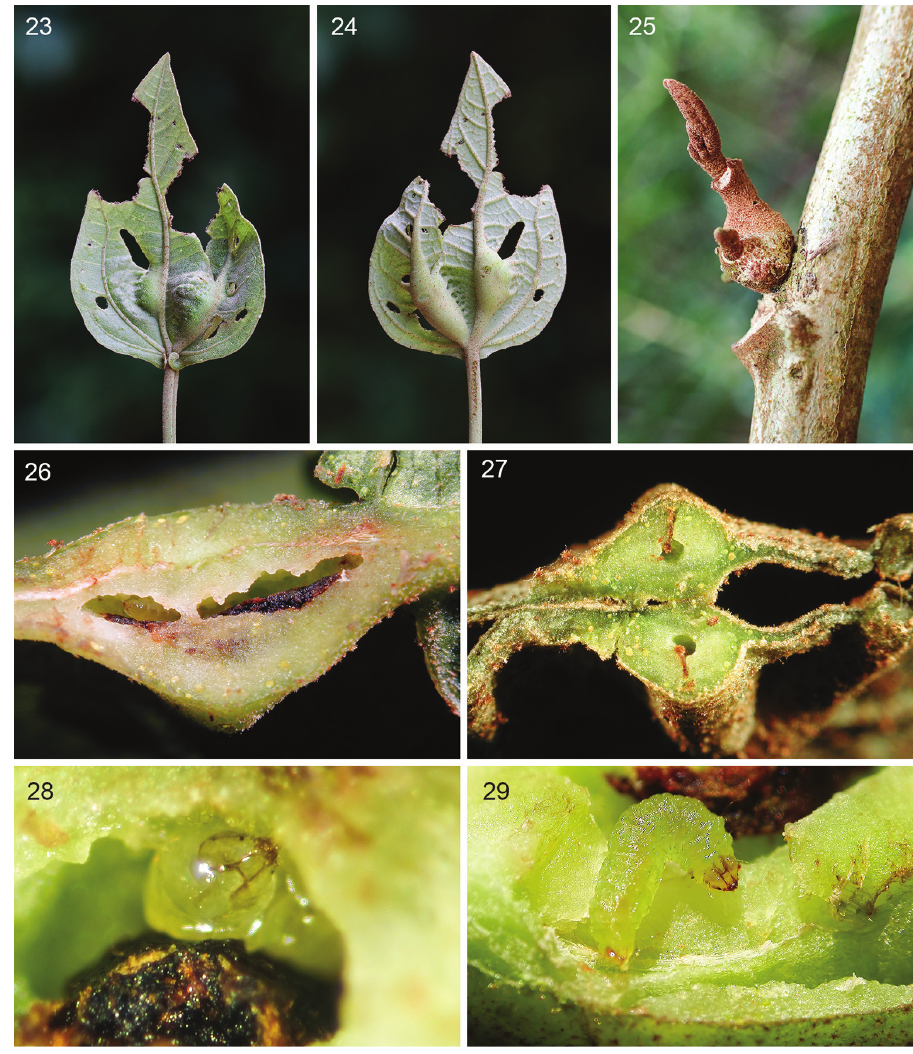
Figures 23–29. Stigmella gallicola , galls and larvae in Hampea appendiculata , details, all at Estación Biológica Monteverde, 1530 m. 23, 24 Galls on primary leaf veins of young leaf, respectively adaxial and abaxial view, 8 June 2016 25 Old gall found at axillary leaf bud, same date 26 Longitudinal cut of mature gall with late instar larva in situ, 20 October 2001 27 Transversely cut leaf (young gall in middle) showing gall chamber and frass mass line, 24 October 2001 28 Late instar larva in situ, note packed frass in gall chamber, same date 29 Late instar larva, dorsal view, slightly ex situ after gall dissection, 4 April